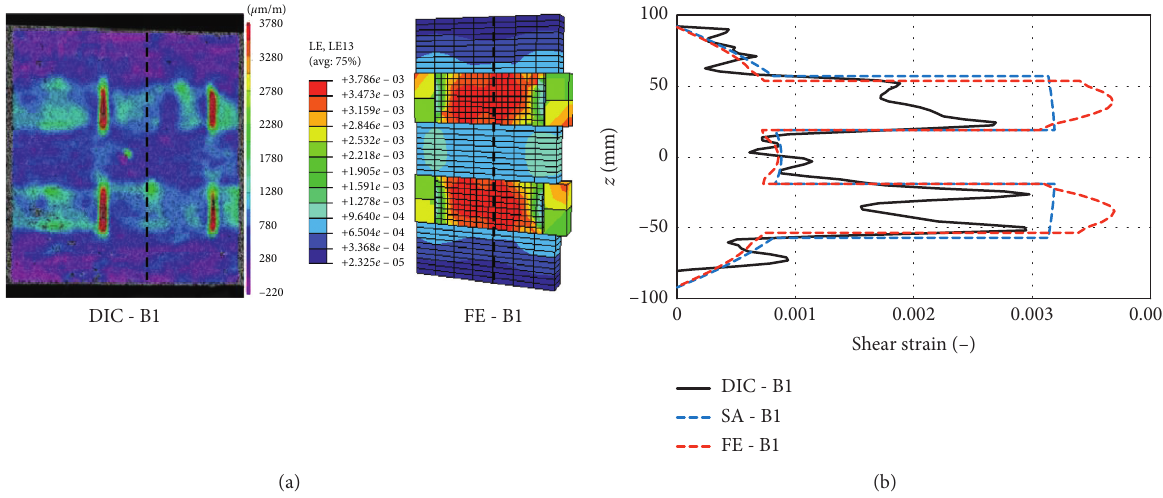
Figure 11: Colour contour plots and shear strain distribution from bending tests for B1.